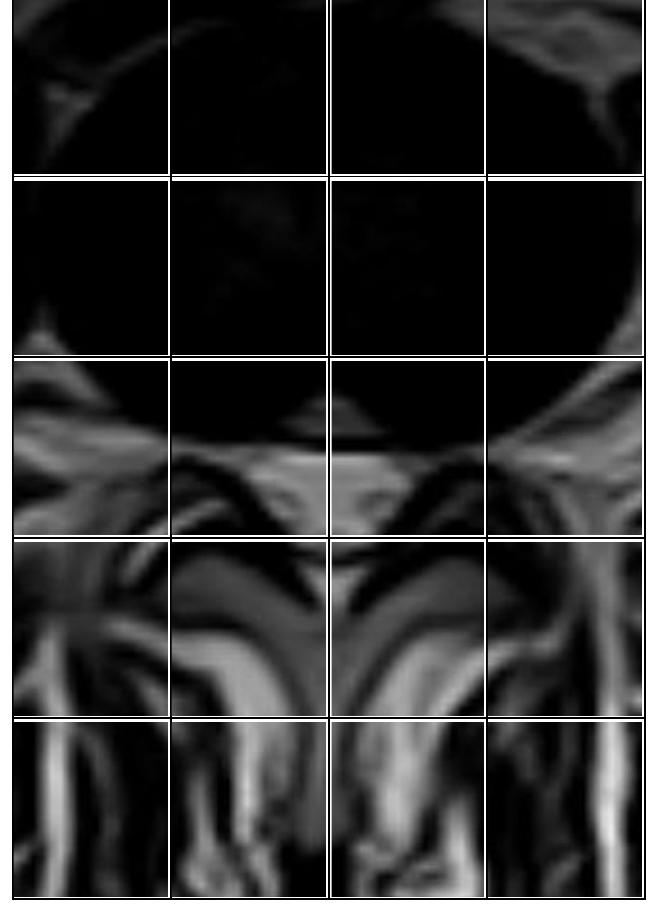
Figure 6. Twenty blocks from an image, each one with size (82 * 94) used to create ROI.